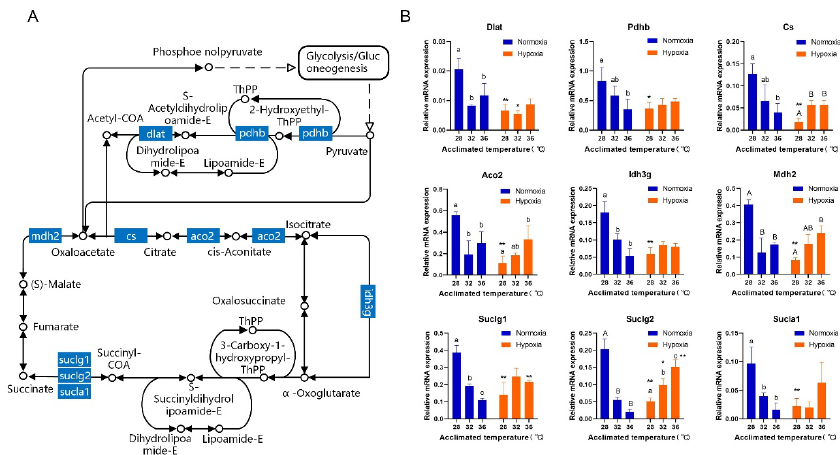
Figure 4. Differential expression of genes involved in the tricarboxylic acid (TCA) cycle pathway at different temperature and oxygenation conditions. ( A ) Inhibition of the TCA cycle in the long-term 36 °C treatment, compared with 28 °C, under normoxia. The black arrow indicates the direction of the reaction, and the gene name in the rectangle illustrates the enzyme that catalyzes the step. The blue shading box indicates down-regulated genes in the 36°C normoxia group ( p < 0.05). Compound names are provided next to the corresponding circles. ( B ) RT-qPCR results of nine genes involved in TCA cycle under different temperature and oxygen content groups. Numbers indicate temperature treatments. Blue and orange coloration indicate normoxia and acute hypoxia, respectively. Provided are the means ± SEM ( n = 9). Statistically significant differences between temperature treatments under normoxia or acute hypoxia are tested by one-way ANOVA, respectively, and the multiple comparisons are indicated with different lowercase ( p < 0.05) or capital letters ( p < 0.01). Statistical differences between normoxia and acute hypoxia under the same temperature are indicated by asterisks; * p < 0.05; ** p <